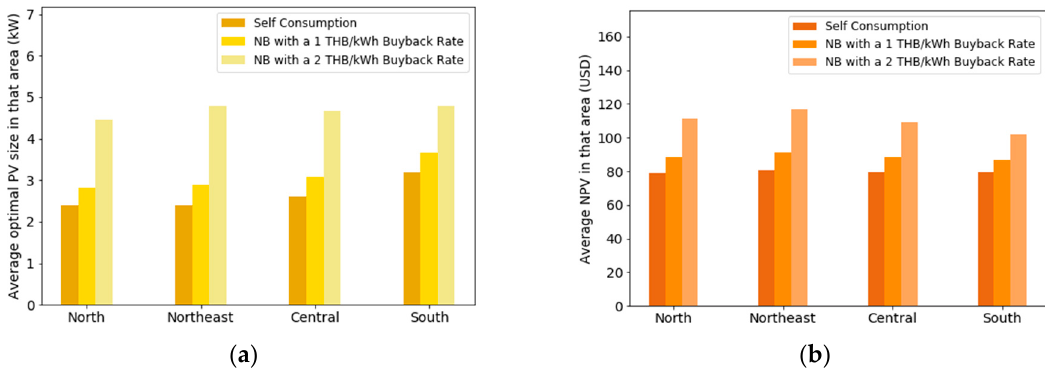
Figure 8. Comparison of ( a ) average optimal PV size and ( b ) NPV by region for SGS customers under a block rate. (Note: The average optimal PV size and the average NPV are the average values among all provinces within a region).